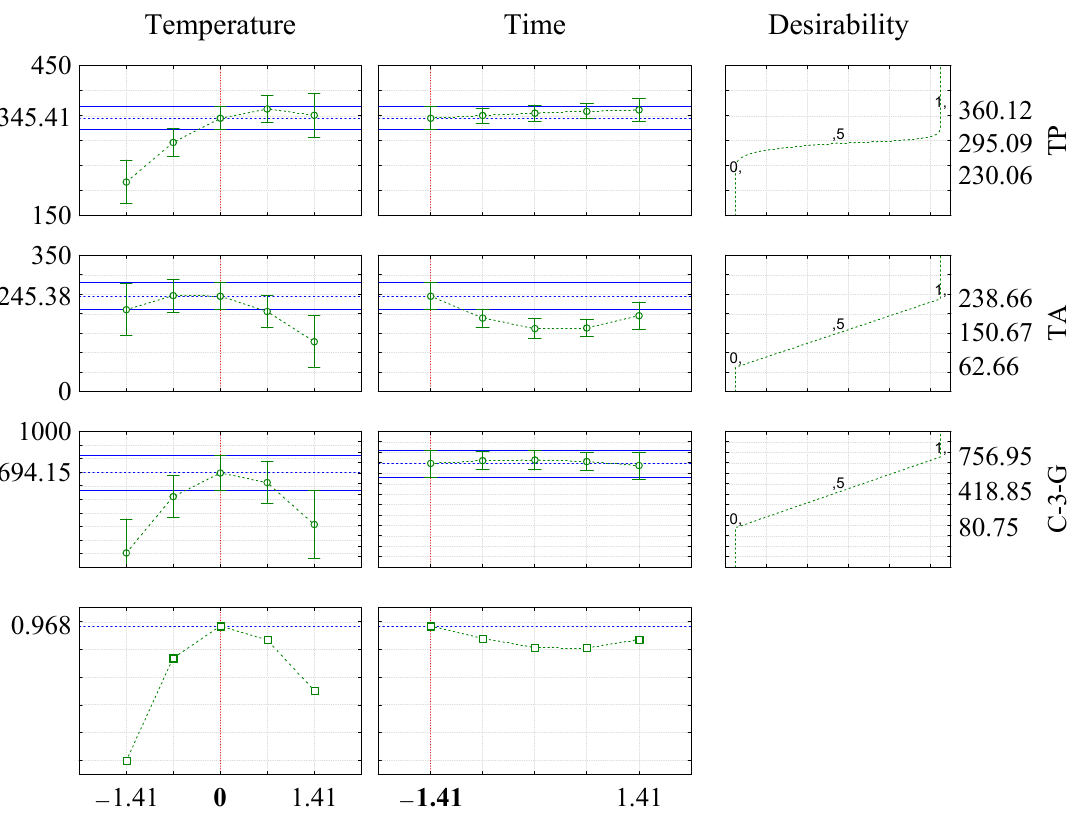
Figure 2. Desirability function for the optimizing conditions for the extraction of bioactive compounds from jaboticaba peels. Table 3. Optimized conditions for the extraction of TP, TA, and C-3-G using MAE, corresponding to the predicted and observed yields.